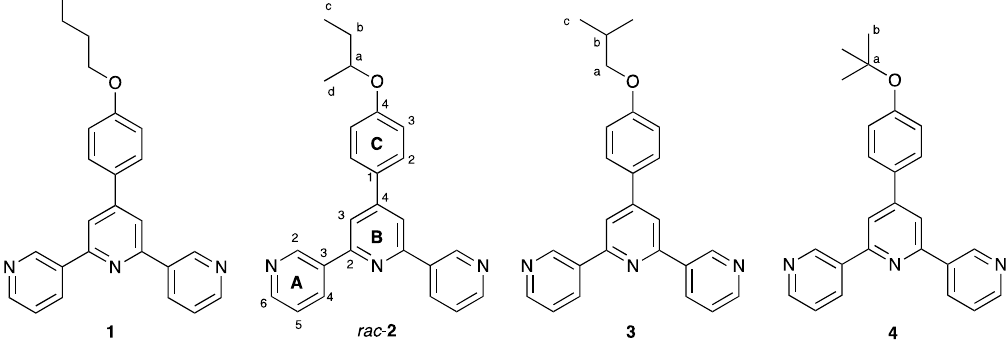
Scheme 2. Structures of the isomeric ligands 1 – 4 with numbering scheme used for NMR spectroscopic assignments. In rac - 2 , C a is a stereogenic center.